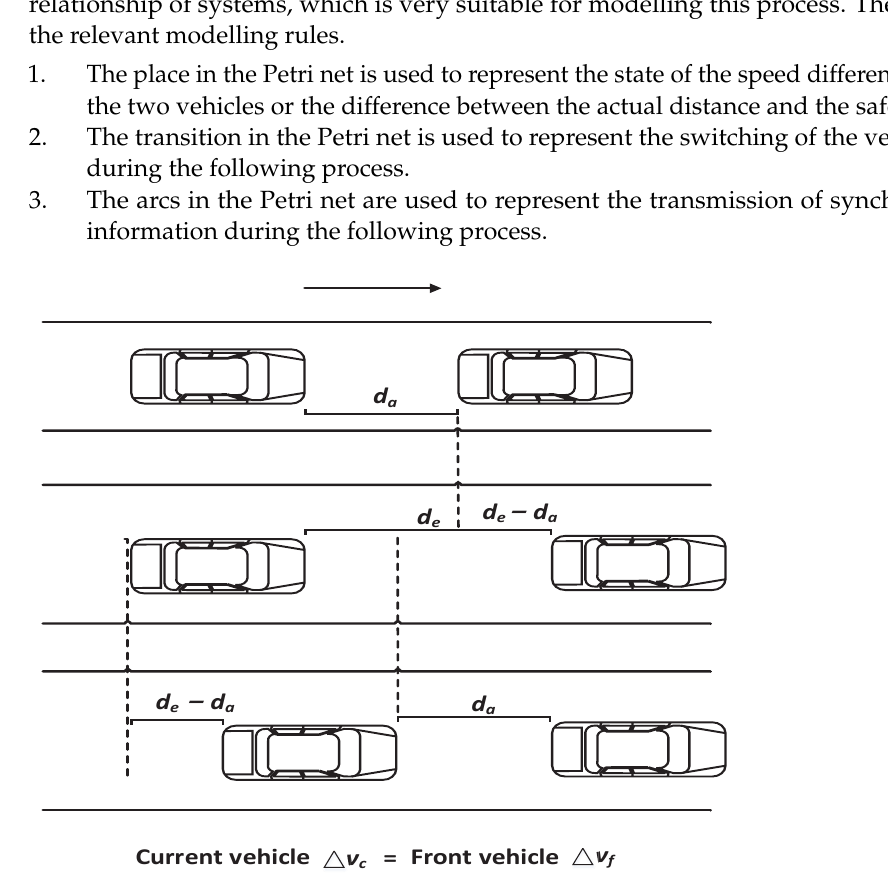
Figure 1. Schematic diagram of